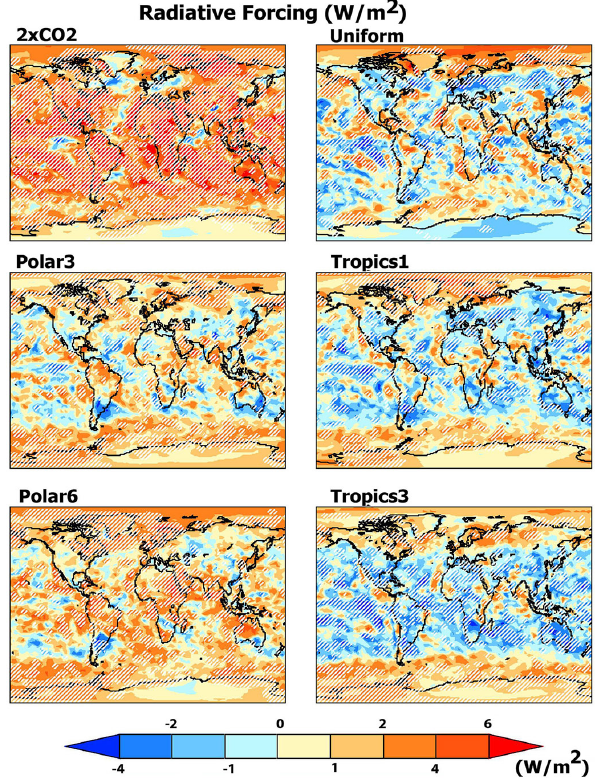
Figure 8. Spatial pattern of radiative forcing in the 2 × CO 2 , Uni- form, and some polar and tropic geoengineering scenarios. In the Uniform and Tropics cases, there is a residual positive forcing in the high latitudes and negative forcing in the low latitudes indicat- ing an inexact compensation. Hatching indicates the region where the changes are significant at 1% level. Significance level was es- timated by Student’s t test. Results shown are averages of the last 20 years of 30-year simulations with fixed sea surface temperature and sea ice fraction.